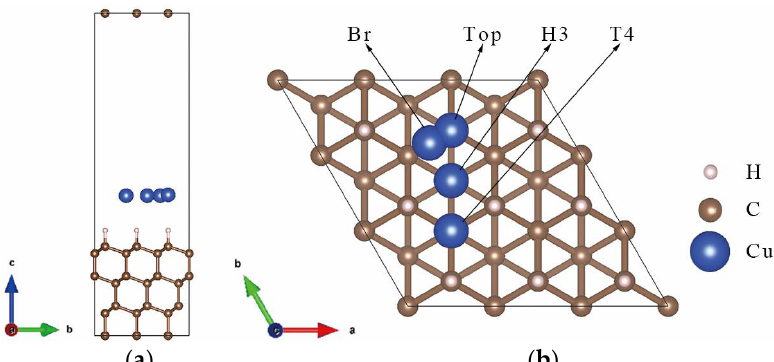
Figure 4. Slab structure model and adsorption sites of Cu atom adsorbed on the surface of H-terminated diamond (111): ( a ) the schematic diagram of the slab model and the adsorption point facing (100), ( b ) the schematic diagram of the slab model and the adsorption point facing the (001) direction. The pink balls represent H atoms, and the brown balls are C atoms. The blue balls are copper atoms.